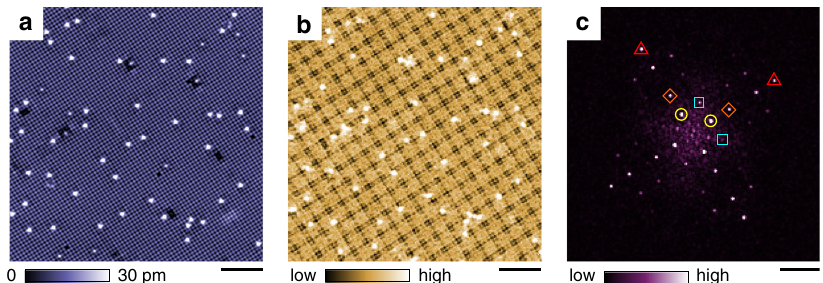
Fig. 2 SI-STM results on the Si-terminated surface at T = 1.5 K and μ 0 H = 2.3 T in Phase II (skyrmion). a Constant-current topographic image. The setup condition is V s = 100 mV and I s = 100 pA. Scale bar 5 nm. b Normalised conductance map L ( r , E = − 20 meV) taken in the same fi eld of view. V s = 100 ¼ 5 mV. Scale bar 5 nm. c Fourier transform (FT) of ( b ). Peaks appear at Q mV, I s = 100 pA, and V mod Q 1 ± Q 2 (blue squares), 2 Q 1 and 2 Q 2 (orange diamonds), and atomic Bragg points G ≡ (1, 0) and (0, 1) (red triangles). Scale bar 1 nm −